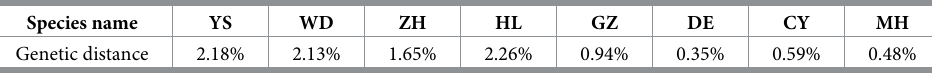
Table 4. Intra-specific genetic distance of 8 species of Actinidia .